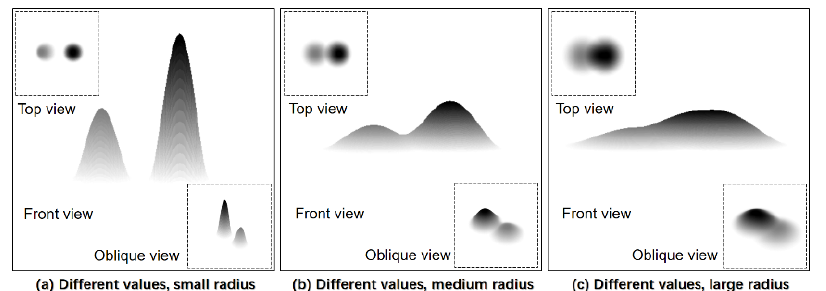
Figure 8. Terrain created by two points with different target attribute values and different search